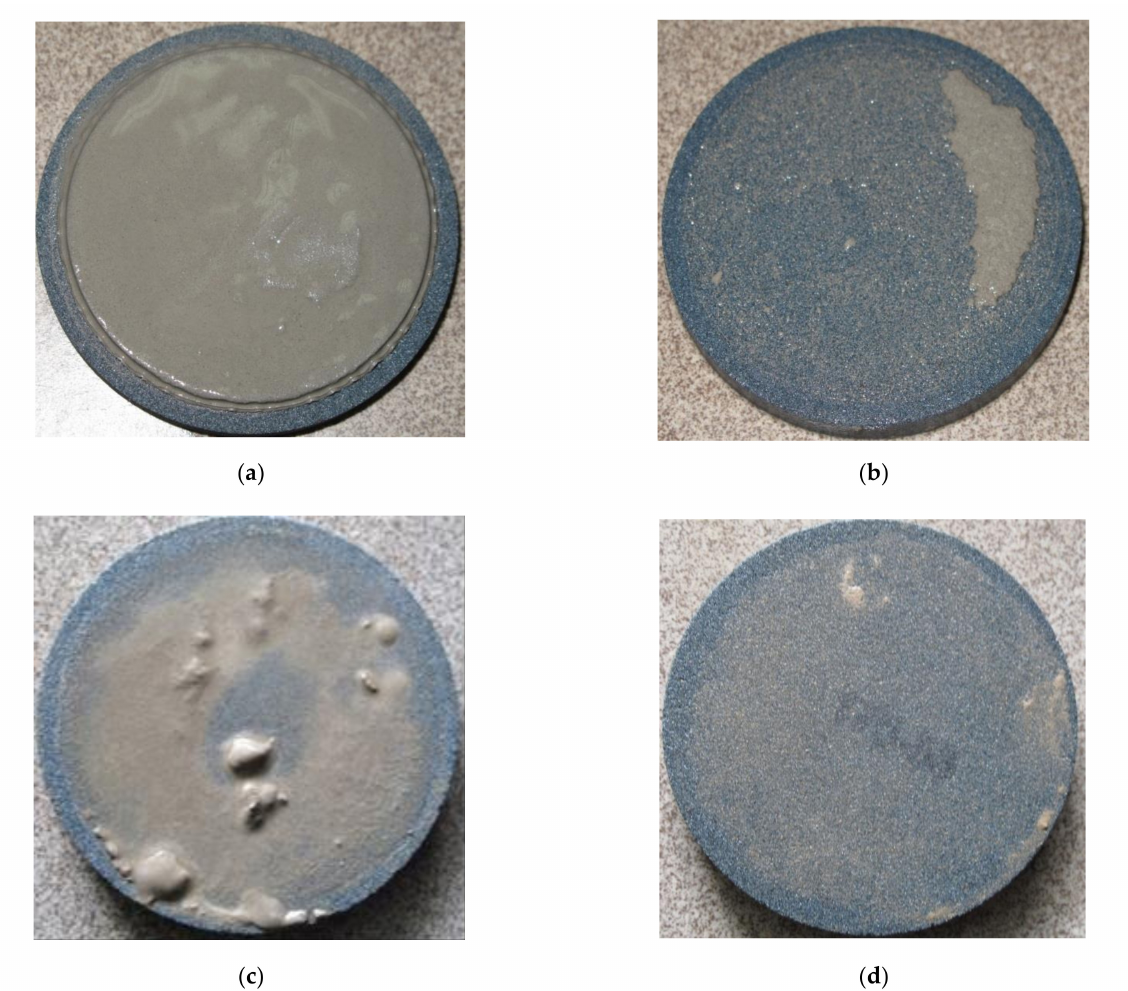
Figure 13. Filter cake produced from the drilling mud taken from the K-1 borehole: ( a ) before eroding, ( b ) eroded with fluid No. 1, ( c ) eroded with fluid No. 2, ( d ) eroded with fluid No. 3.